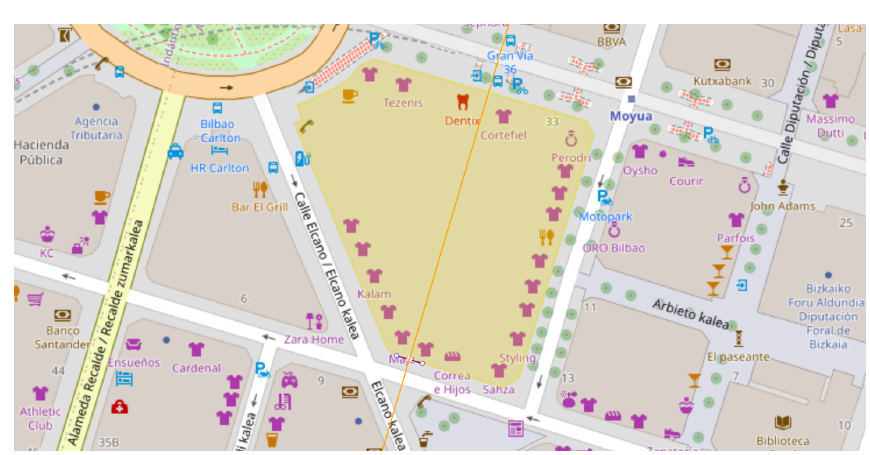
Figure 20. Limit A. 2. Neighbours on consecutive edges . It is checked which of the two points is closest to another edge (see Figure 21). That edge is used as a basis for the same procedure shown in 1.